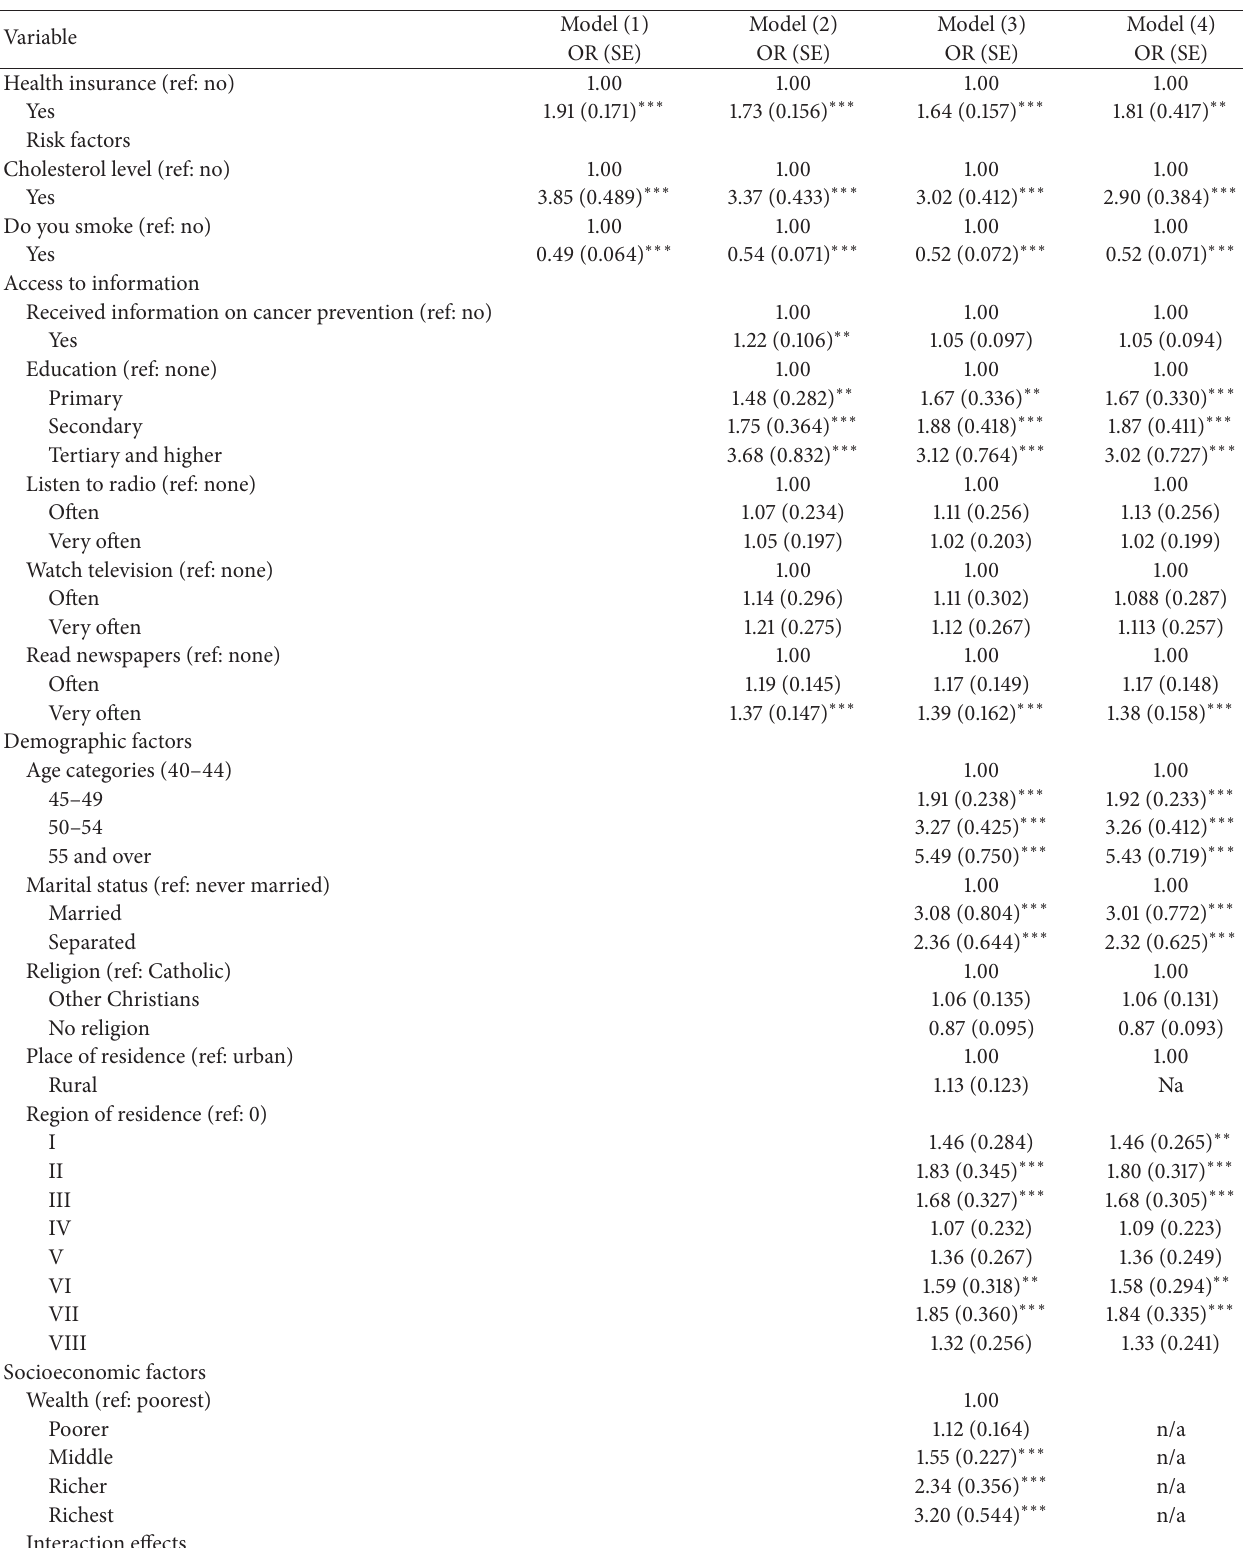
Table 3: Determinants of testing for prostate cancer using hierarchical logistic